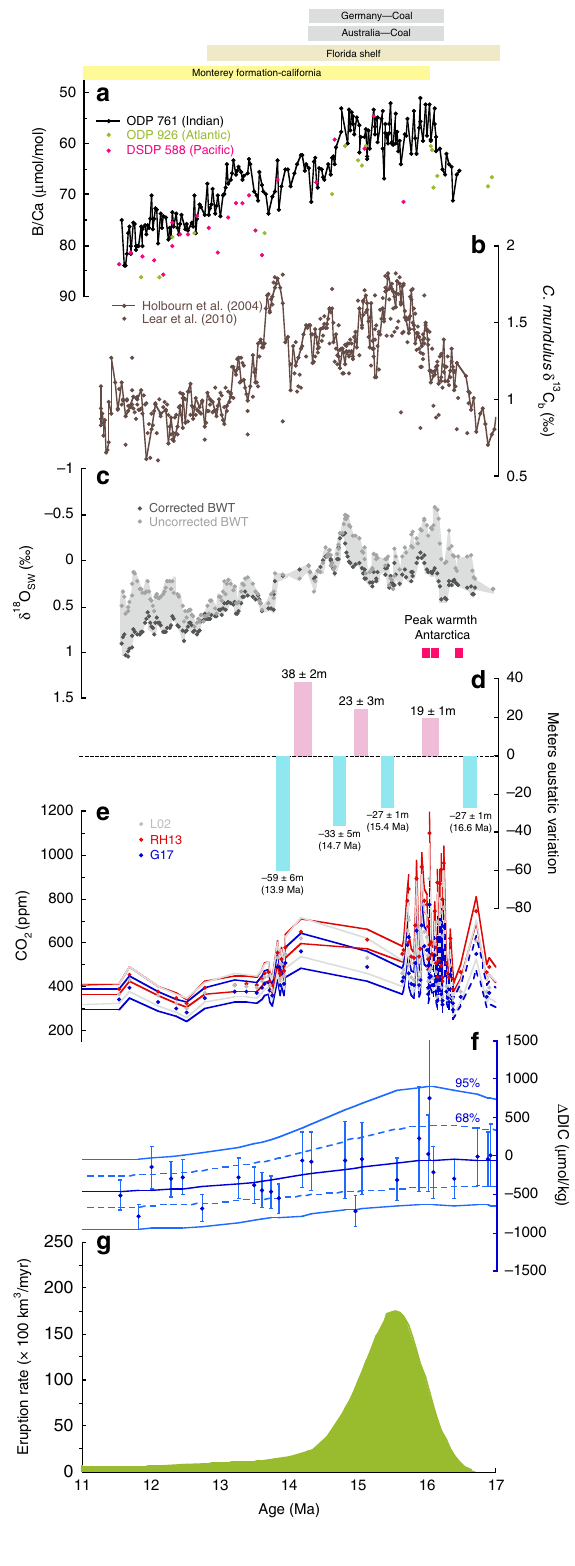
Fig. 4 Paleoclimate records across the middle Miocene. a Planktic foraminifera T. trilobus B/Ca ratios from Indian (ODP 761), Paci fi c (DSDP 588), and Atlantic Oceans (ODP 926) alongside ( b ) benthic foraminiferal δ 13 C 14,21 records from ODP site 761. c Estimates of changes in global ice volume as derived from δ 18 O sw at ODP site 761. Gray circles are uncorrected BWT estimates, whereas dark gray circles are corrected 21 . d Eustatic sea-level change from the Marion Plateau 40 . Intervals of peak warmth in Antarctica as identi fi ed from ANDRILL 15 are highlighted with pink bars (PW3-5). e Boron isotope derived atmospheric CO 2 record 35 using three δ 11 B sw scenarios 66,89,92 (LO2; RH13; G17). f mid- Miocene DIC estimates with Monte Carlo uncertainty envelope using ad hoc B/Ca-B(OH) 4 − /DIC calibration. We plot one δ 11 B sw scenario 35,66 (G17) to highlight overall changes in DIC ( △ DIC) changes and provide full range of DIC estimates in the Methods. Miocene DIC values were subtracted from average MCO DIC levels to calculate △ DIC. g Estimated eruption rate of the Columbia River Basalt 93 . Top bars specify marine (yellow) and land based (green) organic carbon deposition events evident across the Miocene 19,94,95